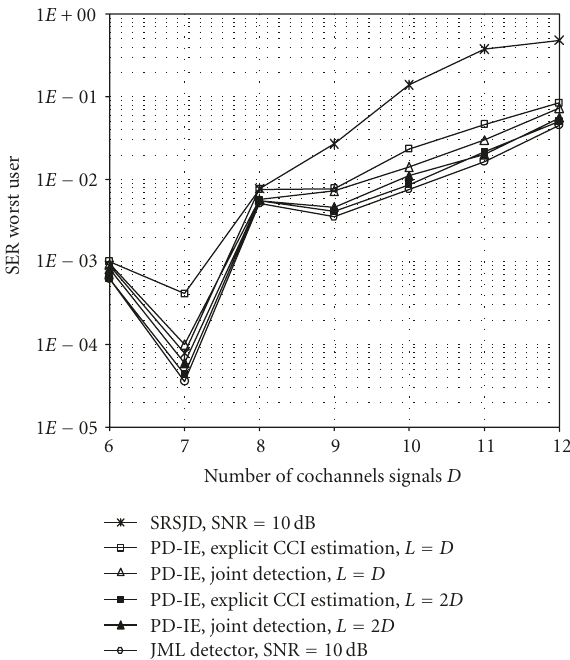
Figure 7: SER of the worst user versus number of cochannel signals at SNR = 10 dB for a 5-element UCA using JML, SRSJD, and PD-IE algorithms. Iteration parameters for PD-IE are shown in Table 1. Figure 8: SER of the worst user versus SNR for PD-IE with list sizes